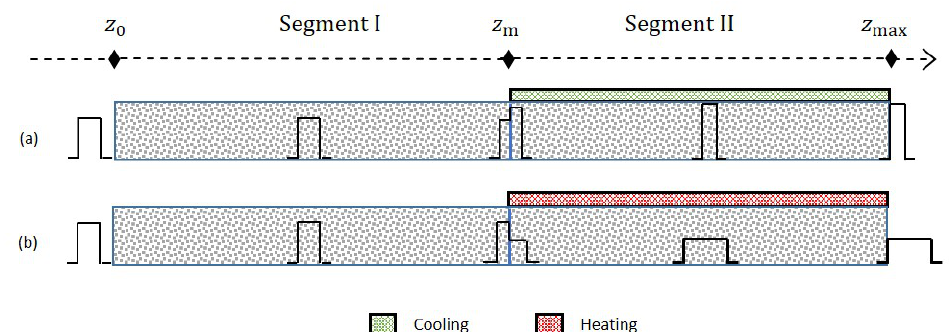
Figure 1. Case ( a ) A single-solute pulse is injected one time into the column. The pulse is allowed to face a low temperature in segment II. As a result, the pulse becomes narrower and more concentrated. Case ( b ) Unlike case ( a ), the injected pulse faces a high temperature in segment II. Then, the pulse becomes broader and less